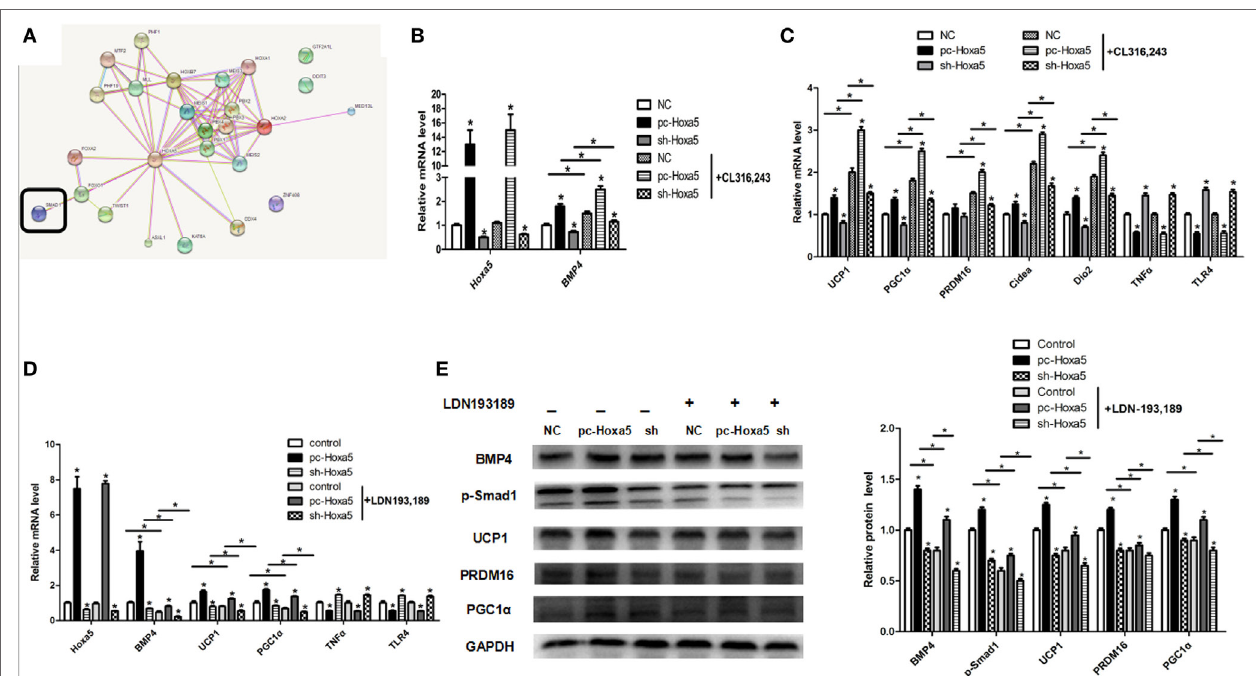
FigUre 8 | Homeobox a5 (Hoxa5) promotes adipocytes browning by activating the BMP4/Smad1 signal pathway. (a) The network of the target genes of Hoxa5 by bioinformatics analysis. (B,c) mRNA expressions of Hoxa5, BMP4, UCP1, PGC1 α , PRDM16, Cidea, Dio2, TNF α , and Toll-like receptor (TLR) 4 in mice adipocytes in the pc-control group, pc-Hoxa5 group, and sh-Hoxa5 group with or without β 3-adrenoceptor agonists CL314,243 ( n = 4). (D) Relative mRNA level of Hoxa5, BMP4, UCP1, PGC1 α , TNF α , and TLR4 in mice adipocytes in control group, pc-Hoxa5 group, and sh-Hoxa5 group with or without Smad1 inhibitor LDN193,189 ( n = 4). (e) Representative immunoblots and densitometric quantification for BMP4, p-Smad1, UCP1, PRDM16, and PGC1 α in mice adipocytes in pc-control group, pc-Hoxa5 group, and sh-Hoxa5 group with or without DN193,189 ( n = 4). Values are represented as means ± SD vs. control group, * p < 0.05.